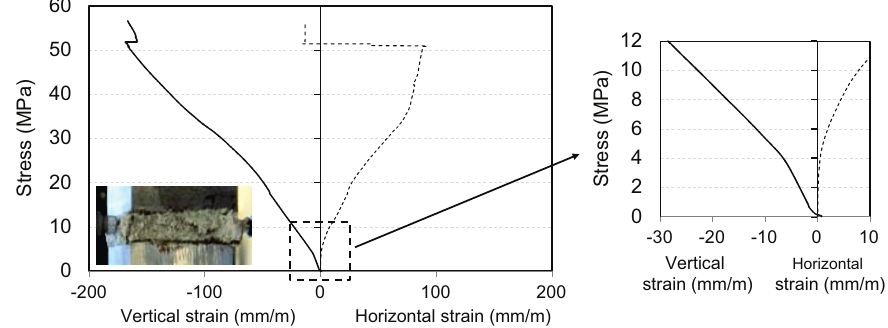
Figure 9 Stress-strain response for a typical small thickness mortar specimen